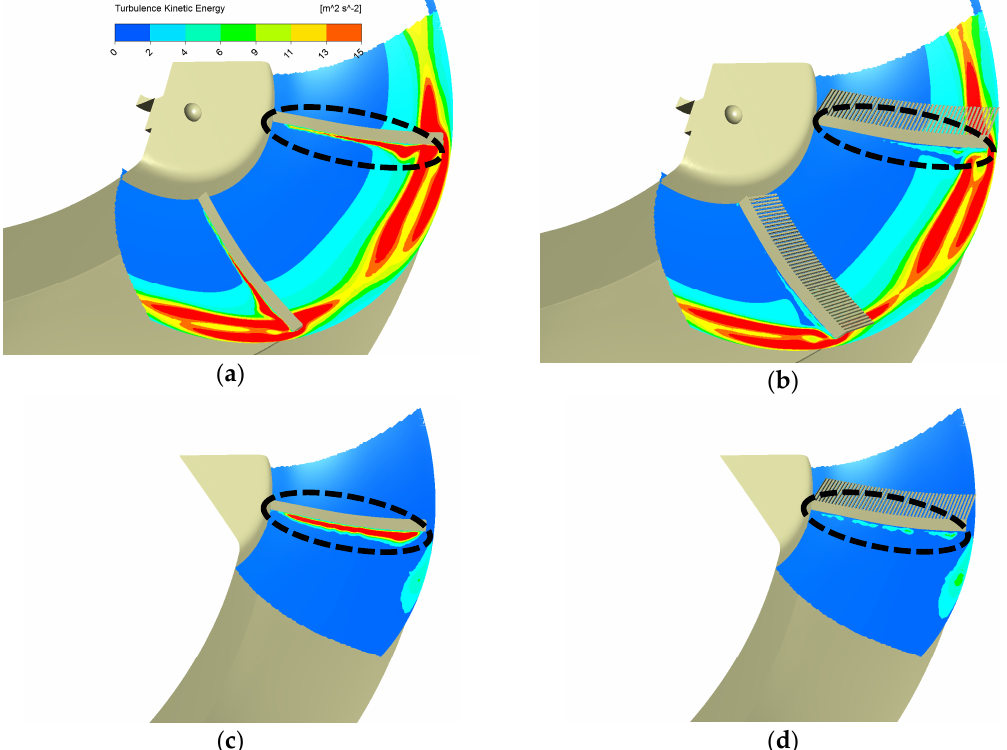
Figure 6. TKE contours on SF_5 mm of the 2-blade full-size model and the single blade model (the following values in brackets are TKE area integrals, unit: m 4 /s 2 ): ( a ) Basic 2-blade full-size model (0.112), ( b ) Serrations’ 2-blade full-size model (0.0997), ( c ) Basic single blade model (0.00990), ( d ) Serrations’ single blade model (0.00406). Note that the reduction of TKE for each blade averagely derived from the 2-blade full-size model is 0.00615, while the value derived from the single blade model is 0.00584. The error is 0.00031, which is 5% of 0.00615.